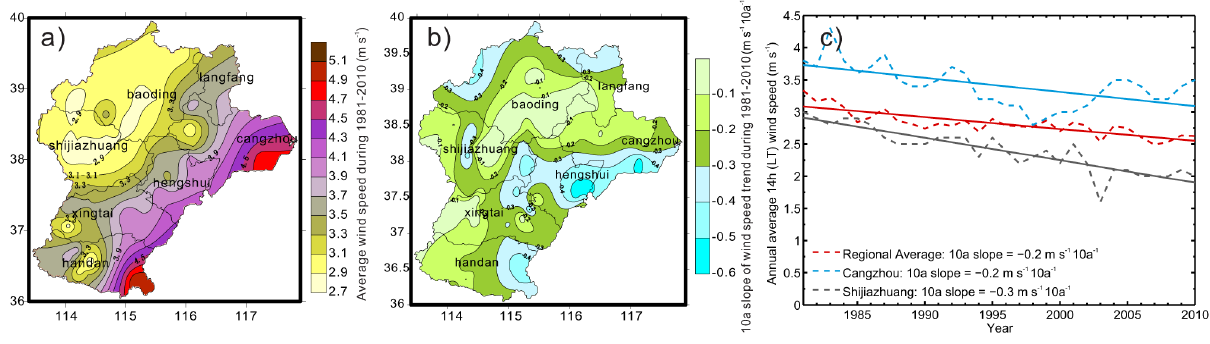
Figure 6. (a) Distribution of the average 14h (LT) wind speed during 1981–2010 in the southern NCP; (b) distribution of the linear slope of the annual wind speed during 1981–2010 in the southern NCP; (c) variation (dashed lines) and linear trend (solid lines) of the regional average 14h (LT) wind speed and that of Cangzhou and Shijiazhuang during